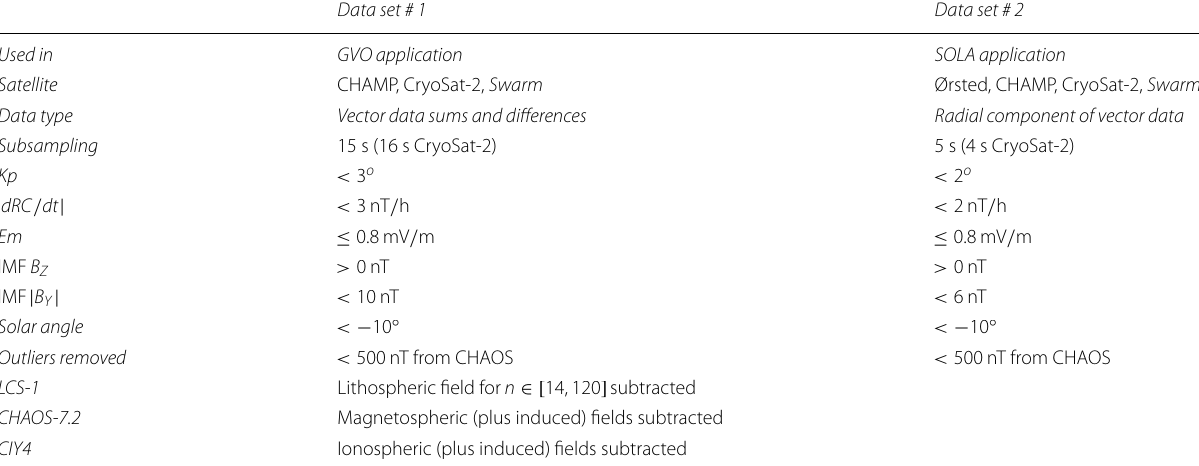
Table 1 Selection criteria, and model corrections applied for the GVO and SOLA datasets used in this study Data set #